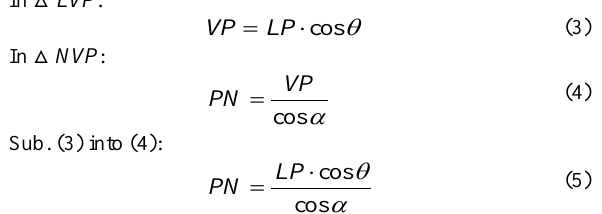
The target cross section σ consists of all target characteristics including the spectral reflectance ρ , the projected target area to the direction of the laser beam A , and the direction of reflection which is determined by the angle θ between the LiDAR sensor and the target . In case of inclined surface, the cosine θ should be the cosine of the angle of reflection θ r which is the angle between the surface normal and the incidence laser pulse as illustrated in figure 1. Nevertheless, few of the previous research work emphasize the importance of the computation of the reflection angle in the RC process. Therefore, section 2.2 describes the mathematical procedures to calculate the θ r .